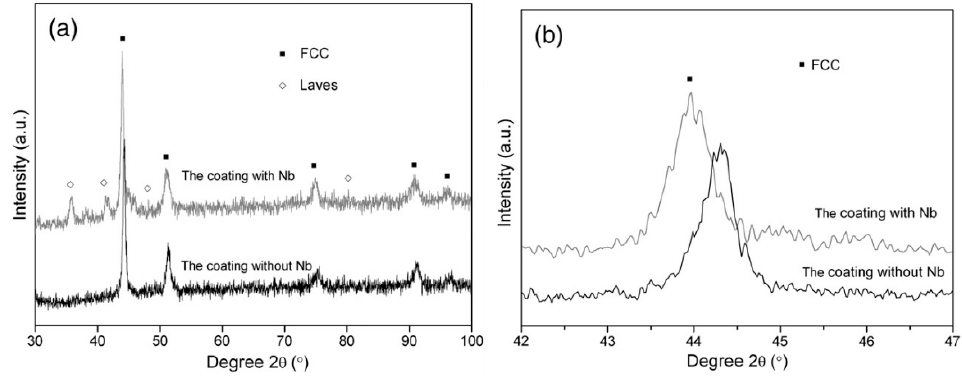
Figure 3. ( a ) XRD patterns of the CoCrCuFeNi and CoCrCuFeNiNb coatings; and ( b ) the detailed scans for the peak of (100) of fcc phase. Reprinted with permission from ref. [84]. Copyright 2014 Elsevier.